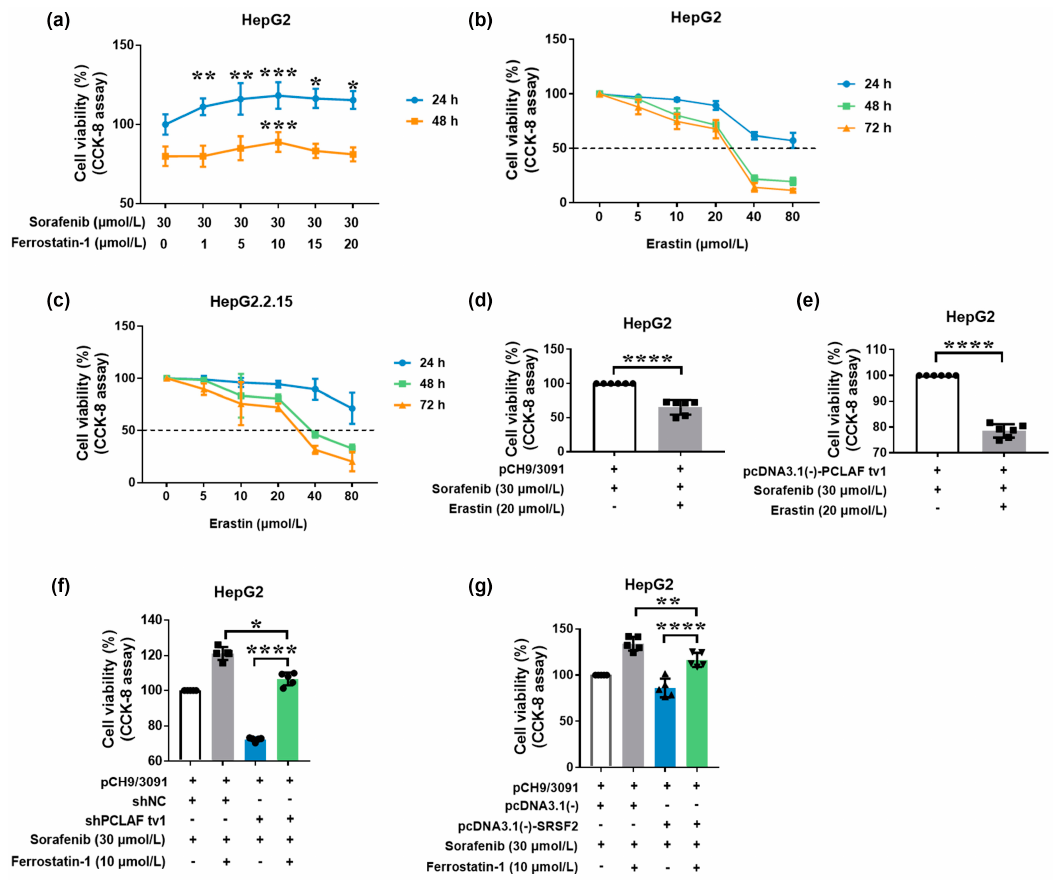
Figure 7. HBV causes sorafenib resistance by suppressing ferroptosis via the SRSF2/PCLAF tv1 axis. HepG2 cells were treated with a variety of ferrostatin-1 concentrations in the presence of 30 μ mol/L of sorafenib. The cell viability was determined using the CCK-8 assay ( a ). The CCK-8 assay was used to determine the cell viability following treatment with various erastin doses in HepG2 ( b ) and HepG2.2.15 cells ( c ). HepG2 cells transiently transfected with pCH9/3091 were treated for 24 h with or without 20 μ mol/L of erastin in the presence of 30 μ mol/L of sorafenib. CCK-8 was then employed to assess cell viability ( d ). HepG2 cells transiently transfected with pcDNA3.1(-)-PCLAF tv1 were treated for 24 h with or without 20 μ mol/L of erastin in the presence of 30 μ mol/L of sorafenib. Then, the cell viability was assessed using CCK-8 ( e ). Transiently co-transfected HepG2 cells with pCH9/3091 and shNC or shPCLAF tv1 were then treated for 24 h with or without 10 µ mol/L of ferrostatin-1 in the presence of 30 µ mol/L of sorafenib. CCK-8 was employed to assess cell viability ( f ). HepG2 cells were transiently co-transfected with pCH9/3091 and pcDNA3.1(-) or pcDMA3.1(-)- SRSF2, then treated for 24 h with or without 10 µ mol/L of ferrostatin-1 in the presence of 30 µ mol/L of sorafenib. CCK-8 was used to test cell viability ( g ). All graphs display the mean ± SD of at least three separate tests. * p < 0.05, ** p < 0.005, *** p < 0.005, **** p <